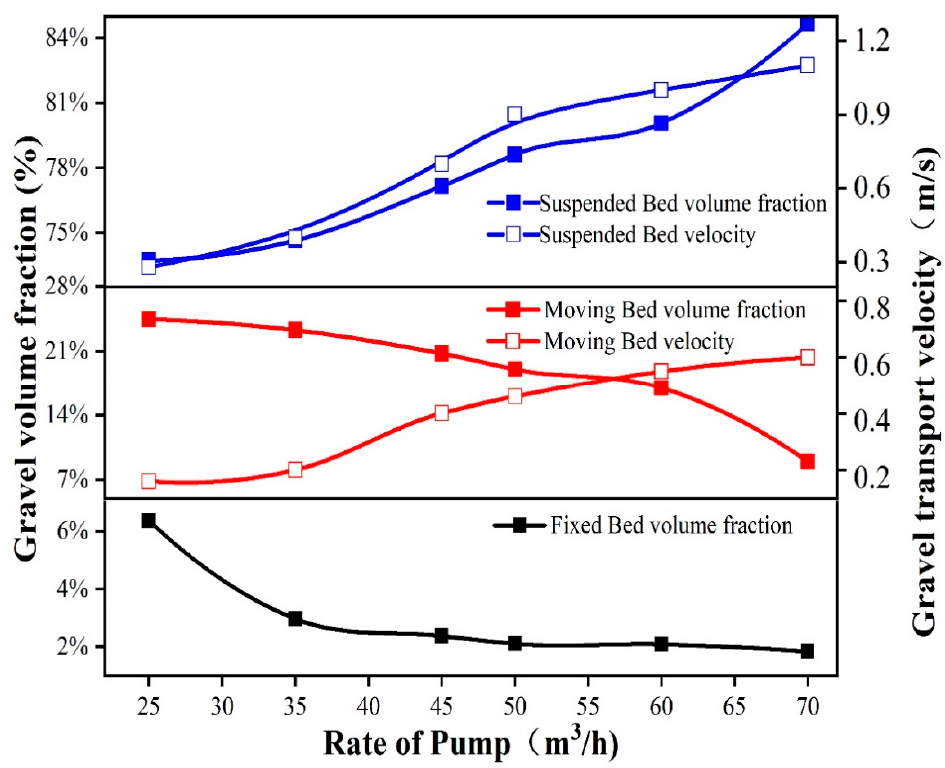
Figure 10. Graph of the effect of displacement on the volume fraction and migration velocity.